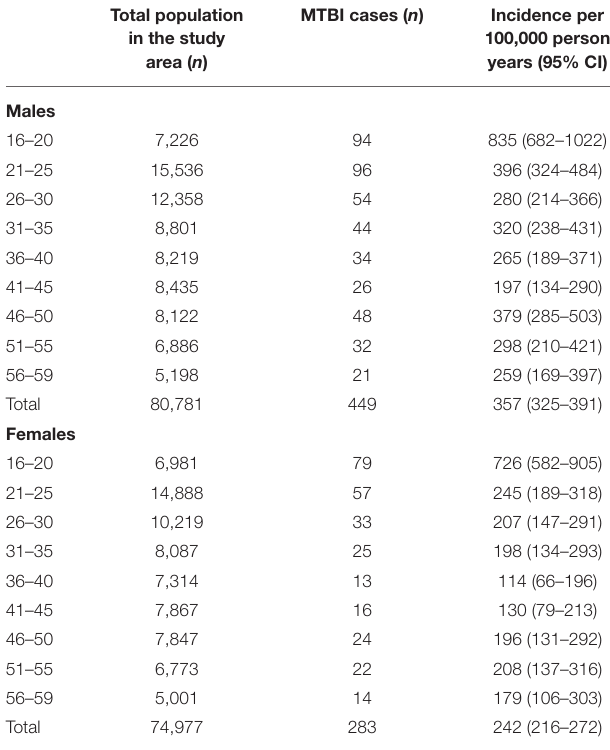
FIGURE 1 | Flow chart of the identification of patients with MTBI. The flow chart demonstrates which figures from the screening procedure that were used for the computation of incidence rates.